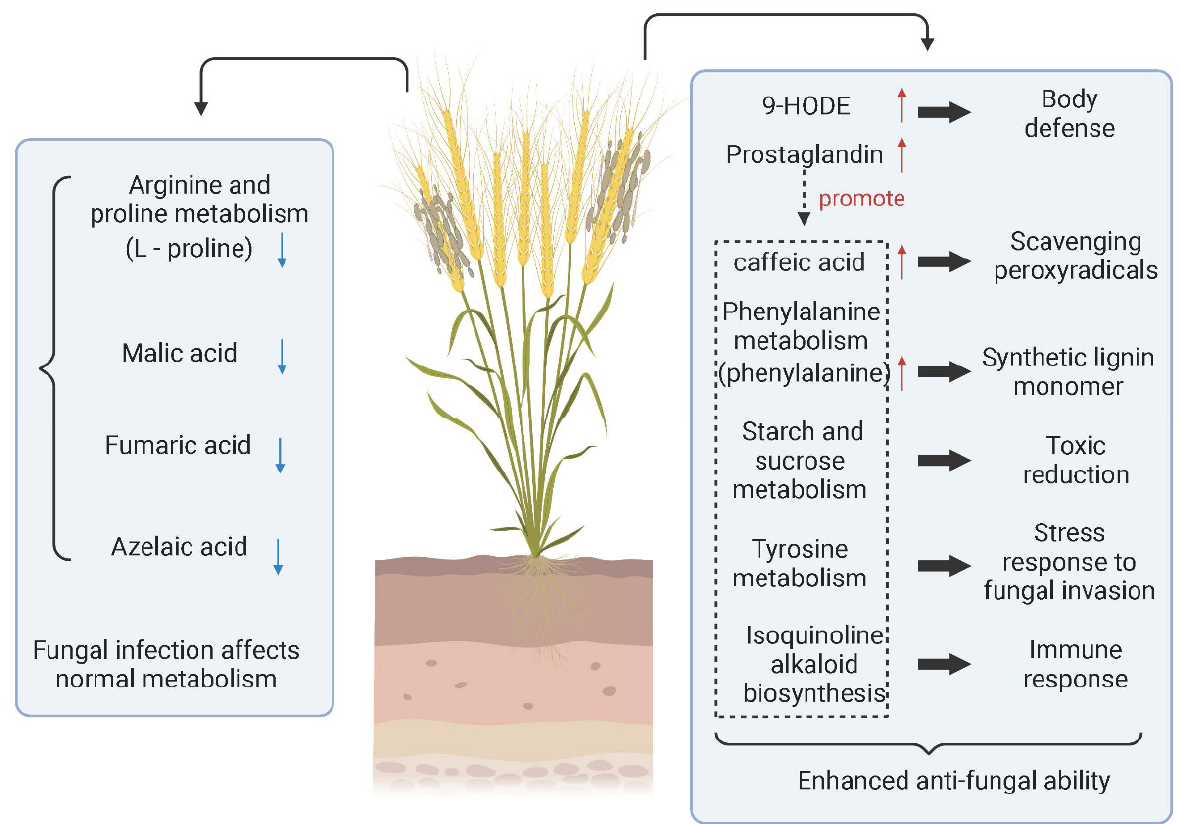
Figure 2. Metabolite changes and metabolic pathways involved in wheat infected with Tilletia controverta. ( ↑ ) represents upregulation and ( ↓ ) represents downregulation. Created with BioRender.com (accessed on 17 May 2022).